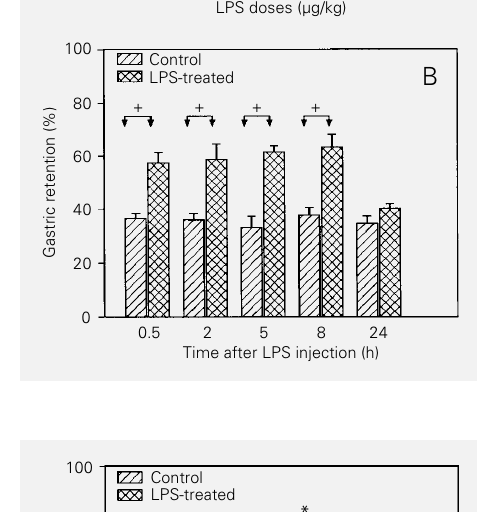
Figure 2 - Effect of vagotomy on the E. coli lipopolysaccharide (LPS)-induced increase in gastric retention of 0.9% NaCl solution by rats. The animals were sub- jected to bilateral subdiaphrag- matic vagotomy 15 days before the test. Gastric retention was evaluated 5 h after the iv admin- istration of LPS (50 (cid:181)g/kg animal weight). The control subgroups received vehicle instead of en- dotoxin. Data are reported as means – SEM for 8 animals in each subgroup. The %GR val- ues between control and treated groups were significantly differ- ent. *P<0.05 compared to the indicated experimental group (Tukey